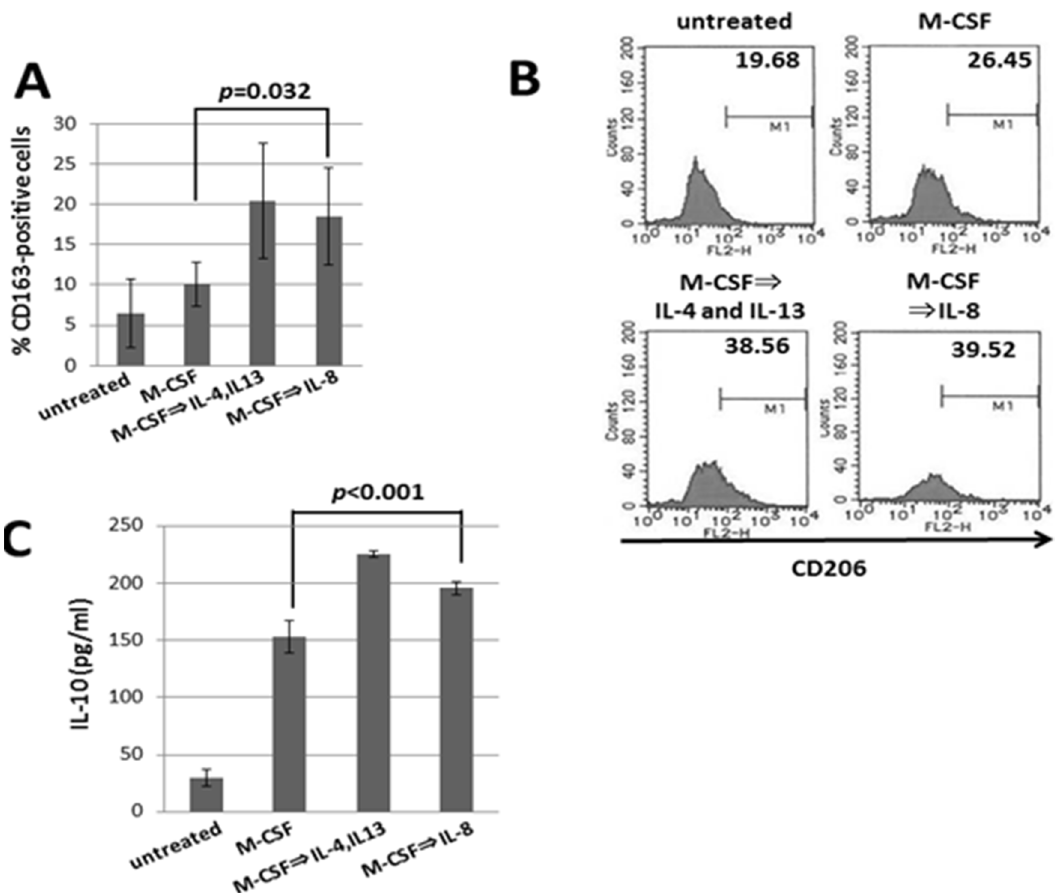
Figure 4. Generation of CD163-positive M2 macrophages by IL-8. Healthy donor-derived monocytes were treated with M-CSF (25 ng/ml) for 5 days and then IL-4 (20 ng/ml) and IL-13 (20 ng/ml) for 2 days, or with M-CSF (25 ng/ml) for 5 days and then IL-8 (10 ng/ml) for 2 days. The cell-surface expression of CD163 (A) and CD206 (B) of the cells was evaluated by using a flow cytometric analysis and IL-10 in the culture supernatants was measured by ELISA (R&D Systems) (C). Bars denote SD of 5 samples.